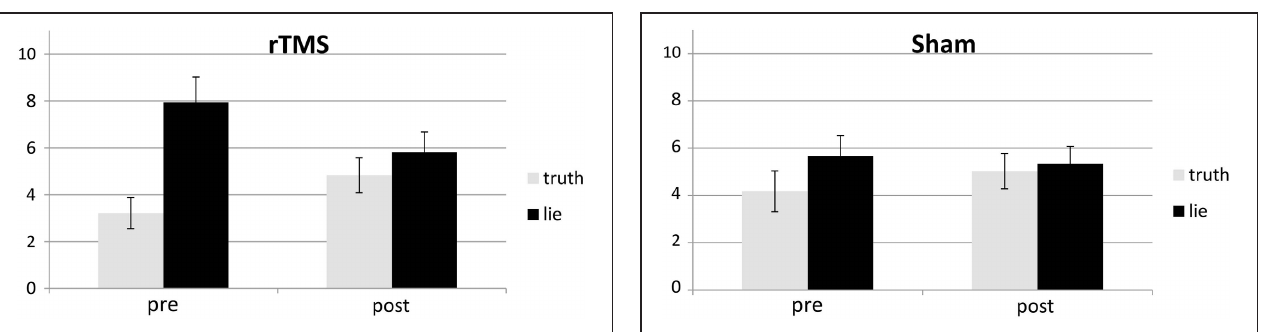
FIGURE 2 | Mean error (in %; ± one SE) for lie and truth trials, pre and post real rTMS.